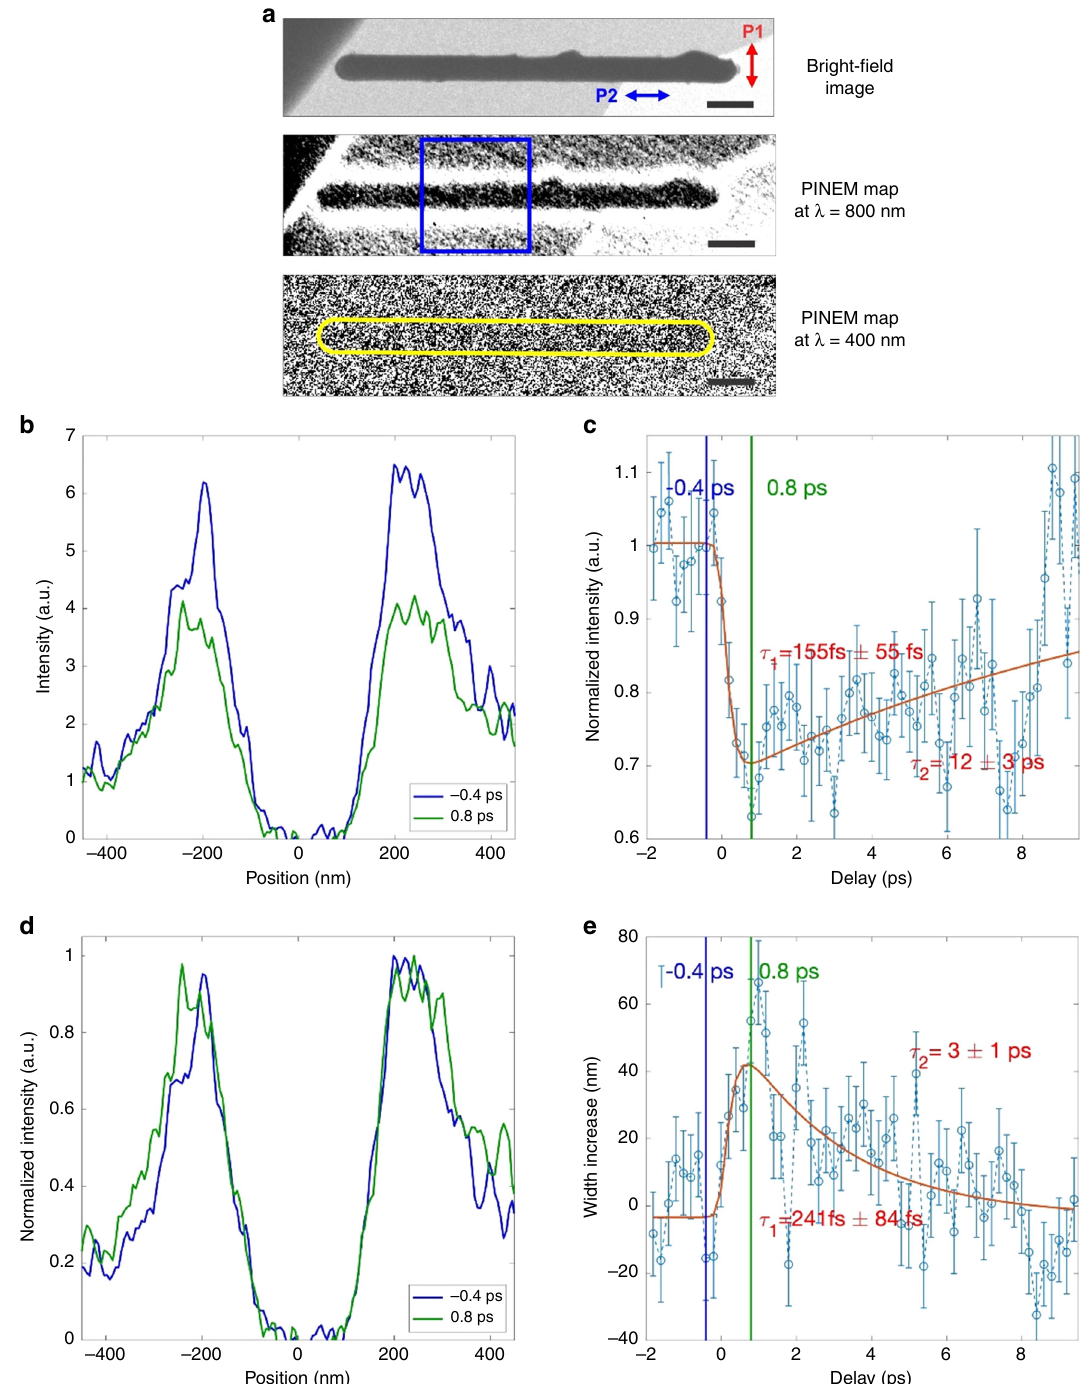
Fig. 4 Two-color PINEM experimental result of a single VO 2 NW. a Bright- fi eld (top panel) and energy- fi ltered PINEM images measured at a pump wavelength of 800nm (middle panel, t 1 = 0 ps) and at 400 nm (bottom panel, t 2 = 0 ps) of the investigated VO 2 NW (~350 nm in diameter) on the Si 3 N 4 substrate. The red and blue arrows in the top panel show the polarization directions of P1 and P2 optical pulses, respectively. The blue box in the middle panel indicates the area along the NW where the PINEM signal is integrated. The scale bars are 500 nm. b Spatial distribution of the PINEM signal across the NW showed at the zero delay time t 2 = − 0.4 ps (coincidence between pump and probe, blue curve) and 0.8 ps (green curve), respectively. c Normalized spatial distribution of the PINEM signal across the NW showed at the zero delay time t 2 = − 0.4 ps (blue curve) and 0.8 ps (green curve), respectively. Both curves are normalized to their own maximum intensity. d Spatially integrated PINEM intensity as a function of delay time ( t 2 ) between the 400 nm pump and the PINEM probe (open circles); the red curve is the best fi t of the experimental data with a biexponential model convoluted with time-resolution of the technique. e Temporal dependence of the lateral spatial decay (measured at full width at half maximum) of the PINEM signal surrounding the NW. The red curve is the fi t with two timescales convoluted with time-resolution of the technique. The error bars have been obtained by considering the measurement uncertainty and the variance within the